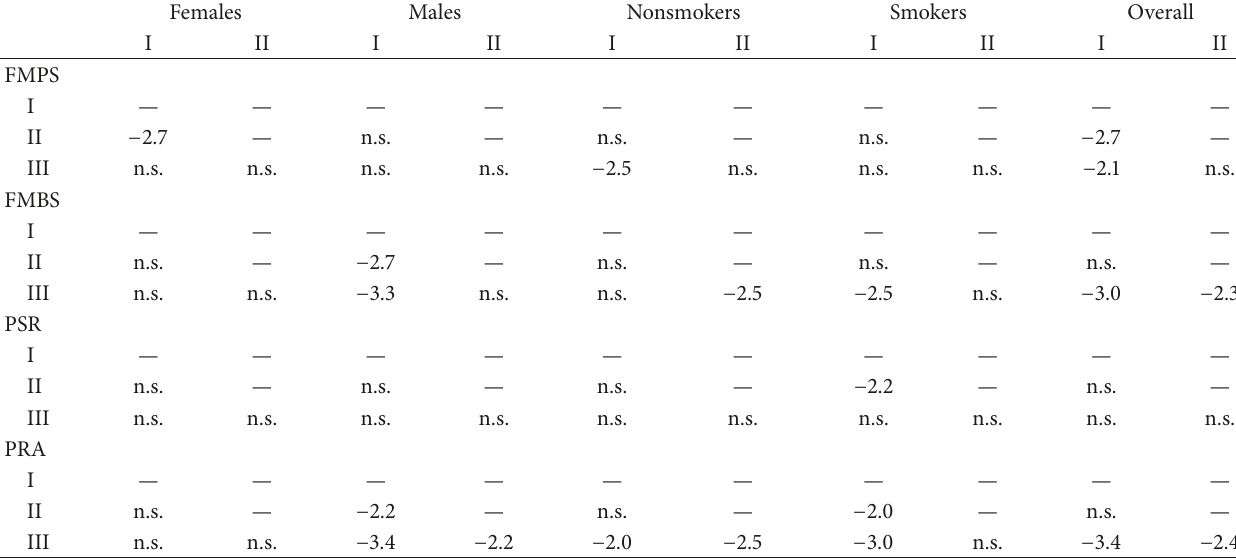
Table 3: Nonparametric analysis of dental indices.